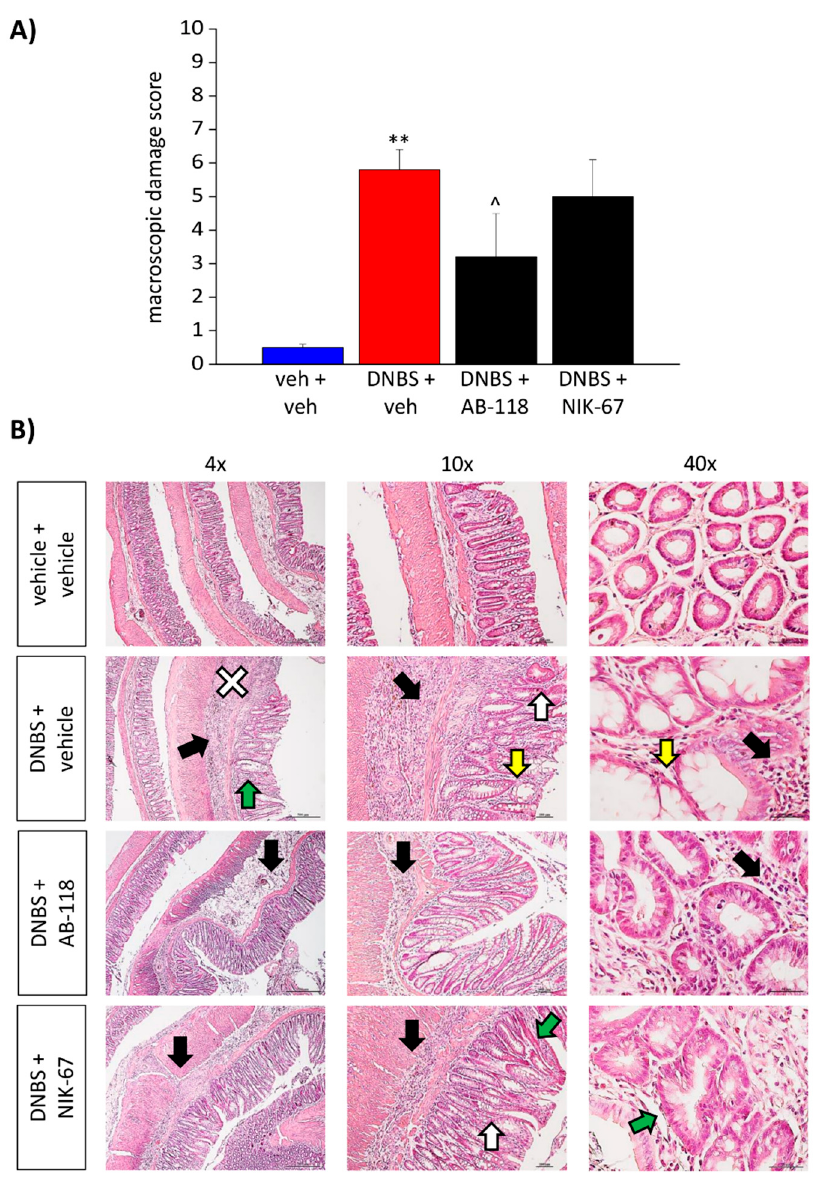
Figure 4. Effect of AB-118 and NIK-67 on the colon damage induced by the injection of DNBS. Colon damage was assessed 15 days after the intrarectal injection of DNBS. A macroscopic damage score (MDS) was assigned to each animal based on the presence of adhesions between colon and other intra ‐ abdominal organs (0–2); the consistency of colonic faecal material (indirect marker of diarrhoea; 0–2); the presence and extension of hyperaemia and macroscopic mucosal damage (0–5); the thickening of colonic wall (mm) ( A ). Microscopic evaluations were performed on sections stained with haematoxylin and eosin (scale bar: 4×, 10× and 40×) with particular attention to: inflammatory cell infiltration (black arrow), loss of epithelium surface (white cross), goblet cell hyperplasia and mucus hypersecretion (yellow arrow), irregular crypts (green arrow), epithelial hyperplasia (visible as crypt elongation, with goblet cell loss; white arrow) ( B ). Each value is the mean ± S.E.M. and represents the mean of 5 rats per group. ** p < 0.01 vs. vehicle + vehicle ‐ treated animals. ^ p < 0.05 vs. DNBS + vehicle ‐ treated animals.